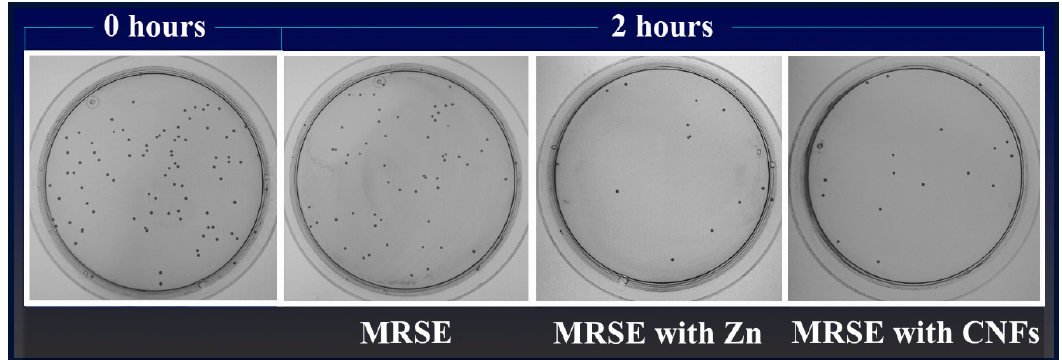
Figure 4. Representative plate images with the Colony Forming Units (CFU) obtained in the antibacterial test of multidrug-resistant Staphylococcus epidermidis (MRSE) cultured in isotonic saline solution, in isotonic saline solution with 80 µg/mL of zinc (MRSE with Zn) and in isotonic saline solution with 80 µg/mL of carbon nanofibers (MRSE with CNFs) at time zero and after 2 h of culture at 37 °C (Dilution factor of 10 − 4 ).